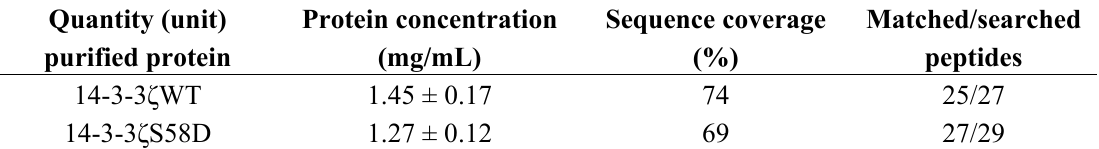
Table 1. Characterization of purified recombinant human 14-3-3 ζ proteins.